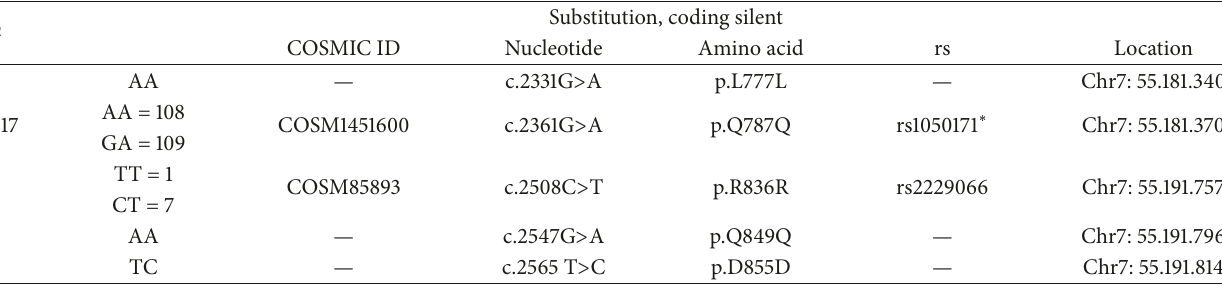
Table 2: Coding silent substitutions in the EGFR